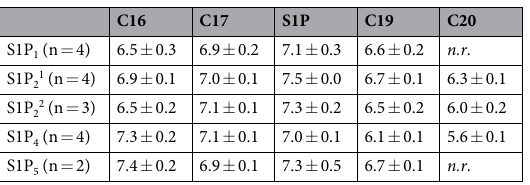
Table 2. pEC50 values of S1P derivatives at S1P receptors. The experimental EC 50 for all S1P derivatives were determined from the dose-response curves of the aequorin-based functional assays. Mean values of pEC 50 (negative logarithm of EC 50 ) on 2 to 4 independent experiments are presented along with the corresponding S.E.M. values. 1 S1P 5 cells, 2 CHO-Aeq cells, n.r . = not reliable.